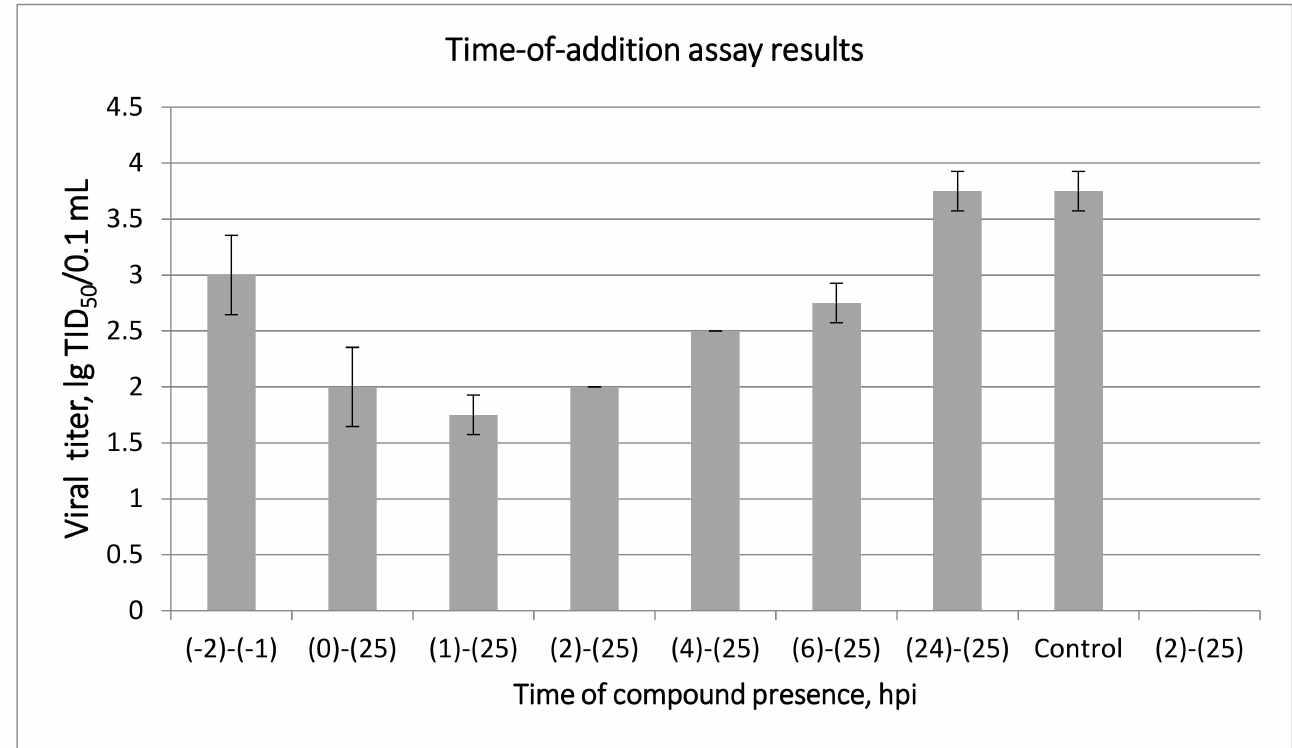
Figure 2. Activity of 19c against RSV A according to time-of-addition